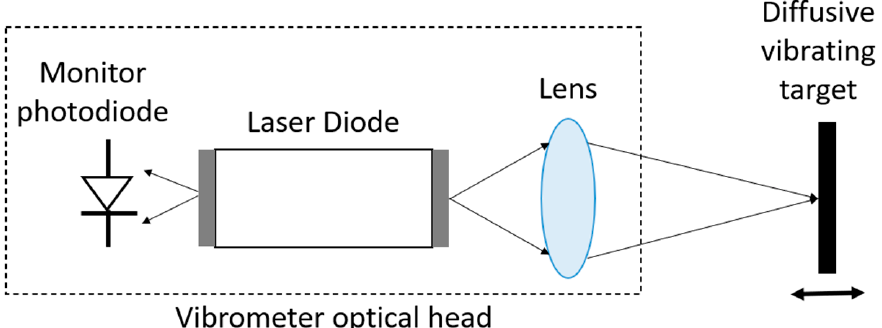
Figure 12. A typical configuration of a self-mixing LDV.